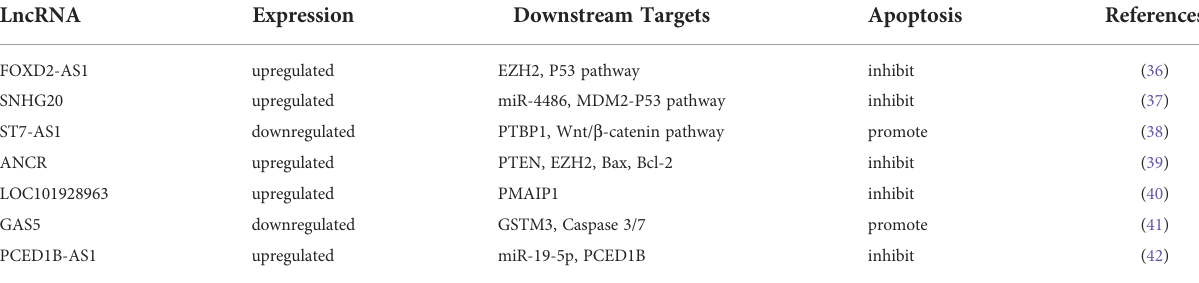
TABLE 2 Representative lncRNAs and related signaling pathways in glioma